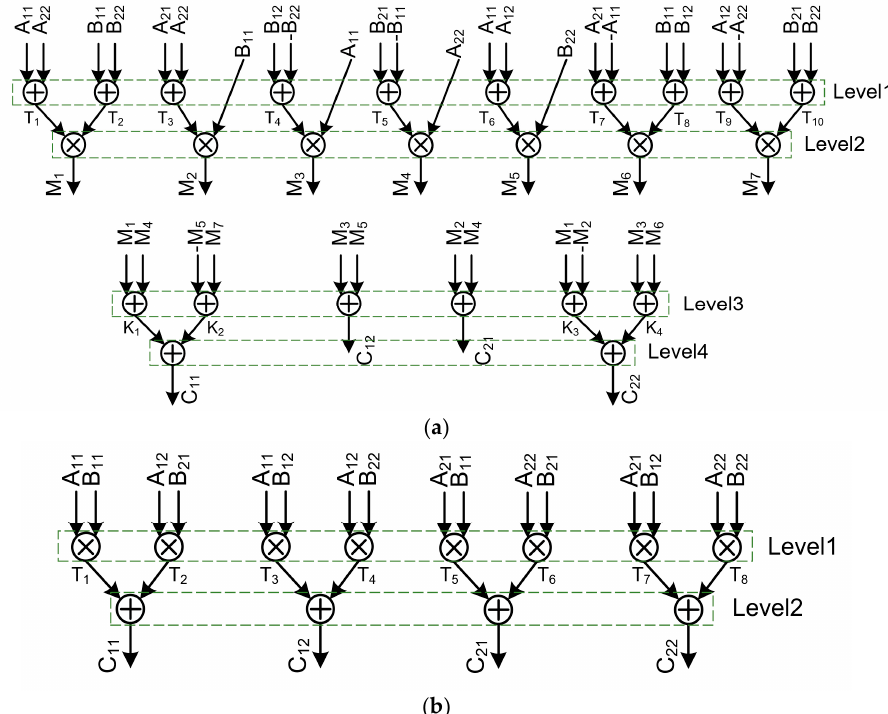
Figure 3. Illustration of a 2 × 2 matrix multiplication step: ( a ) Strassen; ( b ) Naïve.